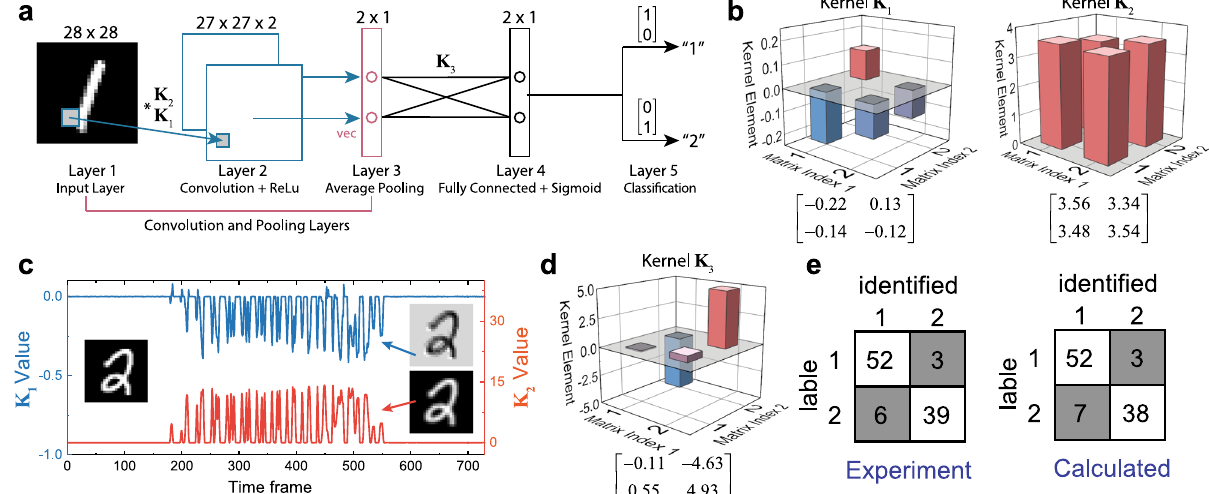
Fig. 4 Building an optical CNN for imaging recognition. a Operation procedure of using the OCNN to recognize handwriting numbers from the MNIST database. The OCNN consists of a convolution layer with two kernels, a pooling and a fully connected layer. The output gives the answer whether the input image is “ 1 ” or “ 2 ” . b The convolution kernel matrices K 1 and K 2 generated by training the OCNN. c . Raw output data of the convolution layer of two kernel matrices. d The weight bank matrix used in the fully connected layer. e The recognition results from the experiment with the OCNN (left) and the calculation with a computer (right) show an excellent